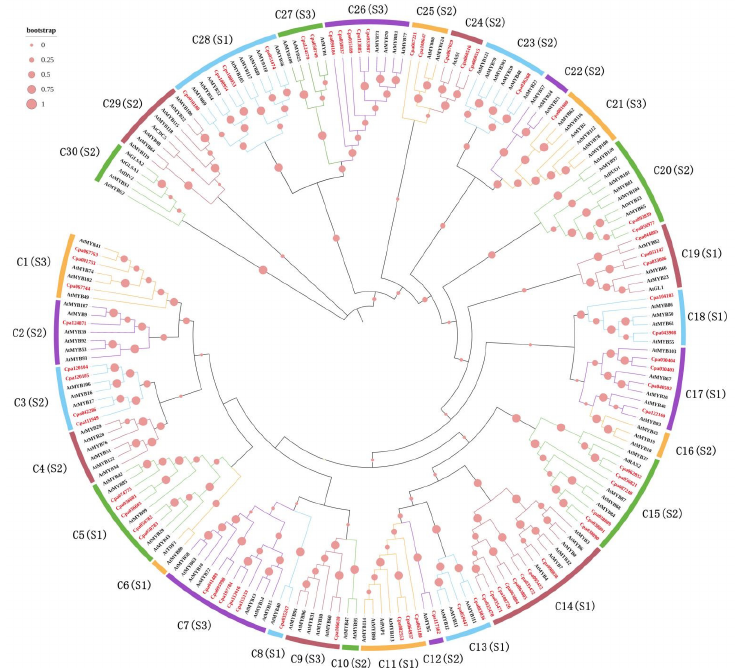
Figure 1. Phylogenetic tree and classification of R2R3-MYB subfamily proteins in A. thaliana and C. paliurus . The number of MYB proteins of A. thaliana and C. paliurus is 120 and 69, respectively. The red dots represent boot values—the larger the dot, the larger the bootstrap value. The names of genes typed in red represent CpaMYBs and those in black represent AtMYBs. S1–S3 represent three subgroups and C1–C30 represent 30 clades of the tree. For example, C5 (S1) indicates that these MYBs are grouped into C5 clade, which belongs to S1